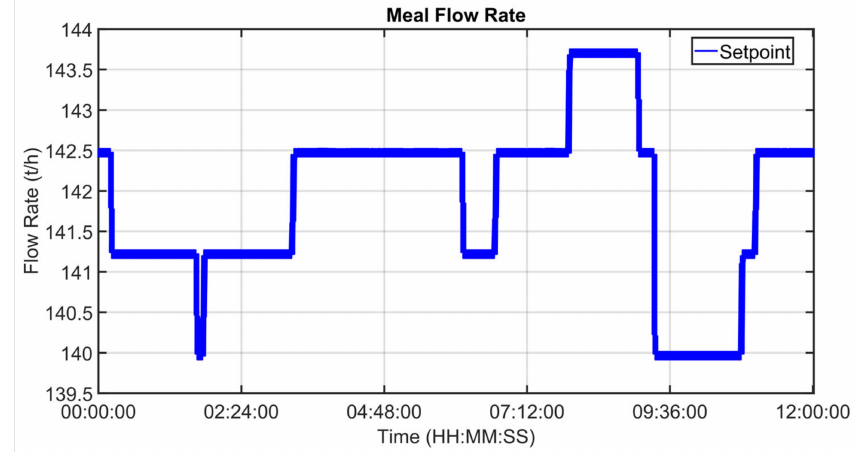
Figure 31. Grate cooler APC system: field results (meal flow rate DV).